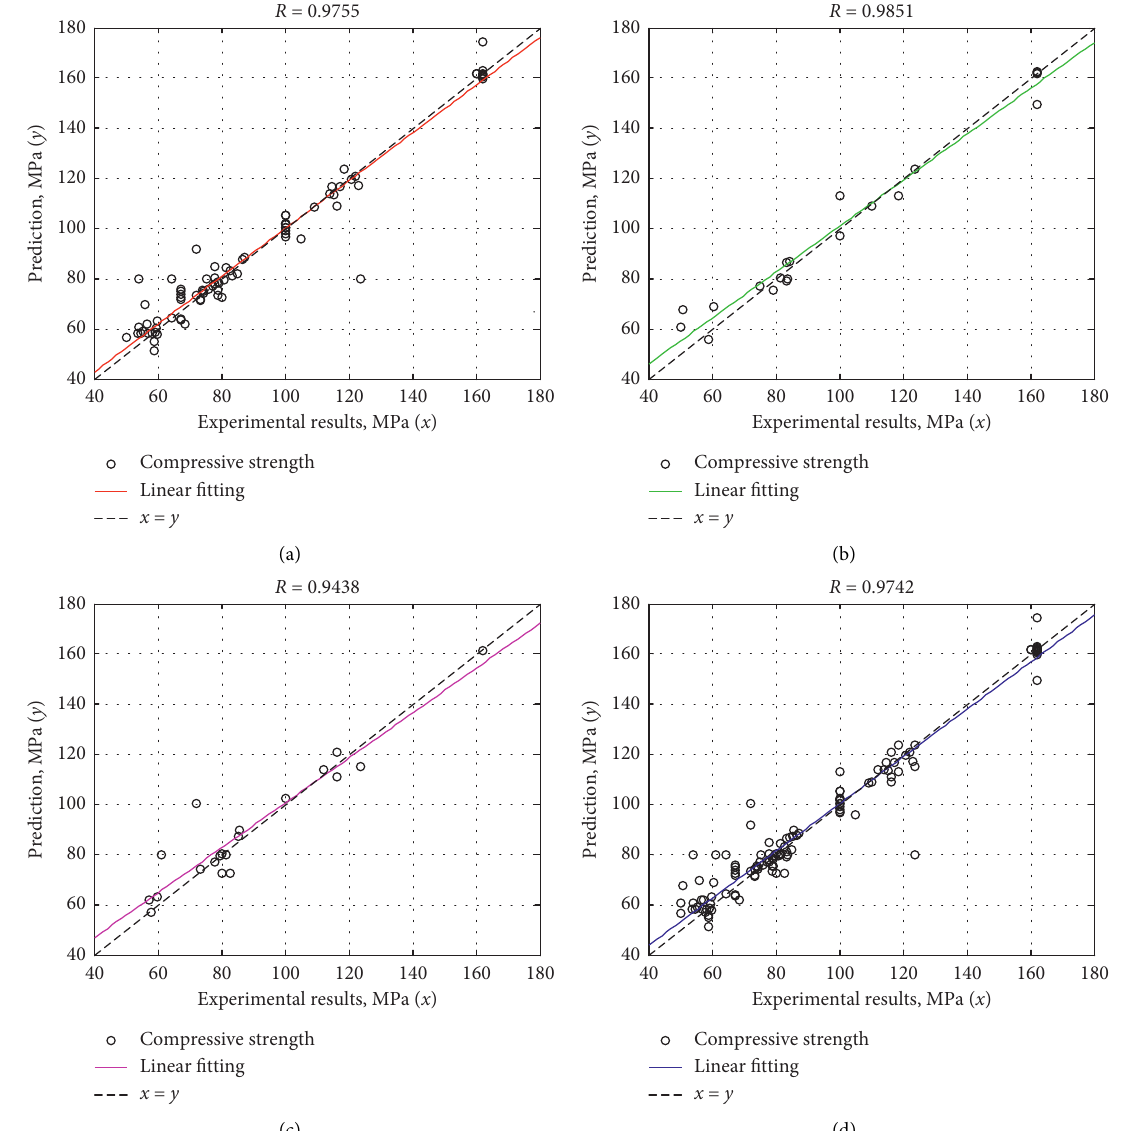
Figure 7: Linear regression plot of ANN performance. (a) Training. (b) Validation. (c) Testing. (d)